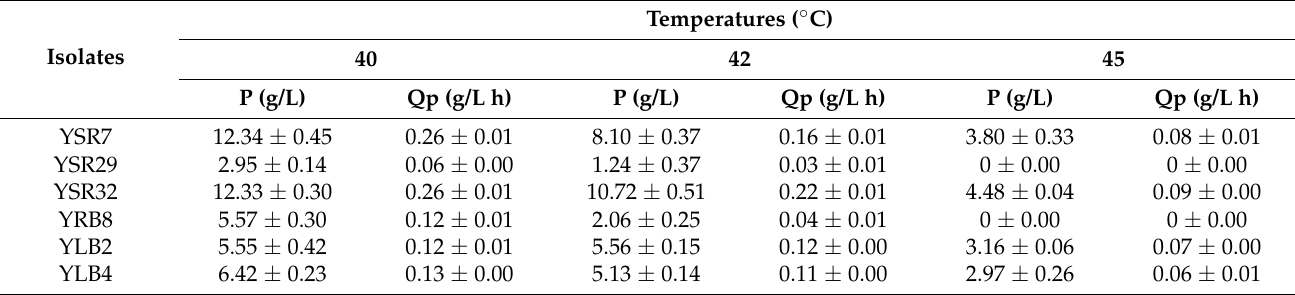
Table 3. Ethanol production potential of the selected yeast isolates at high temperatures using 50 g/L xylose as